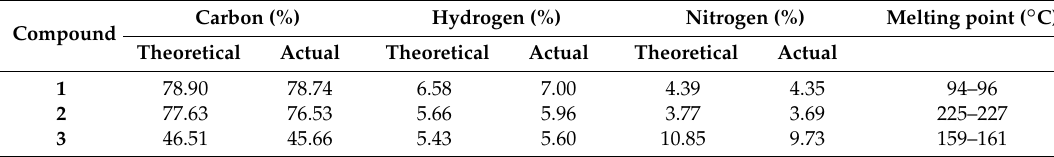
Table 1. Percentage of carbon, hydrogen, and nitrogen and melting point of synthesised compounds. Compound